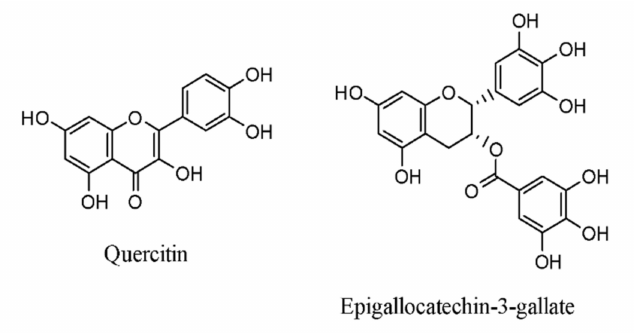
Figure 3. Structural representation of